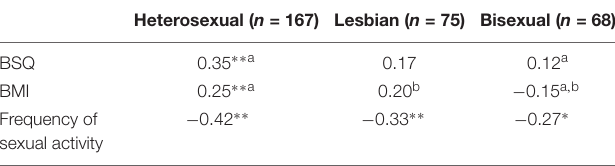
TABLE 3 | Correlations between BSQ and BMI scores (Pearson) and frequency of sexual activity (Spearman), with sexual dissatisfaction (ISS) by sexual orientation.